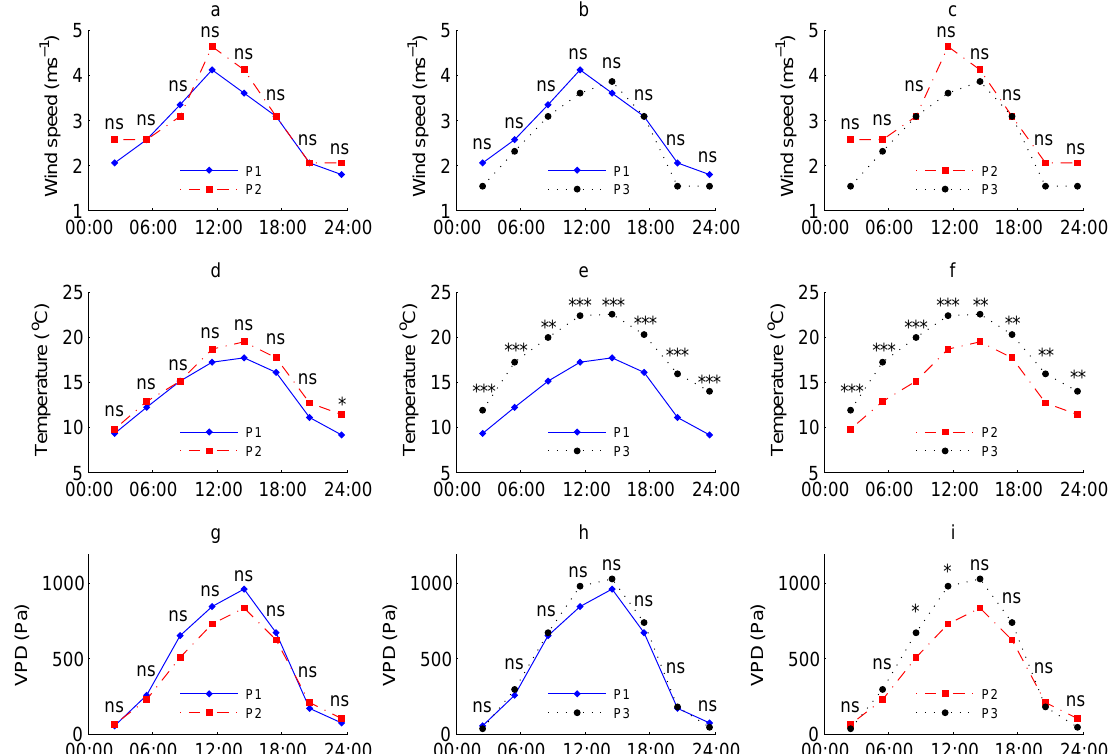
Fig. 5. Pairwise median diurnal profiles for wind speed (a–c) , temperature (d–f) and VPD (g–i) for Period 1 (P1, n = 16), Period 2 (P2, n = 17) and Period 3 (P3, n = 24). Results of the two-tailed Wilcoxon rank sum test are indicated for each three-hour weather data averaging period, with “ns” indicating no significant difference and “ ? ”, “ ?? ” and “ ??? ” indicating significant differences at the 95, 99 and 99.9% levels respectively.